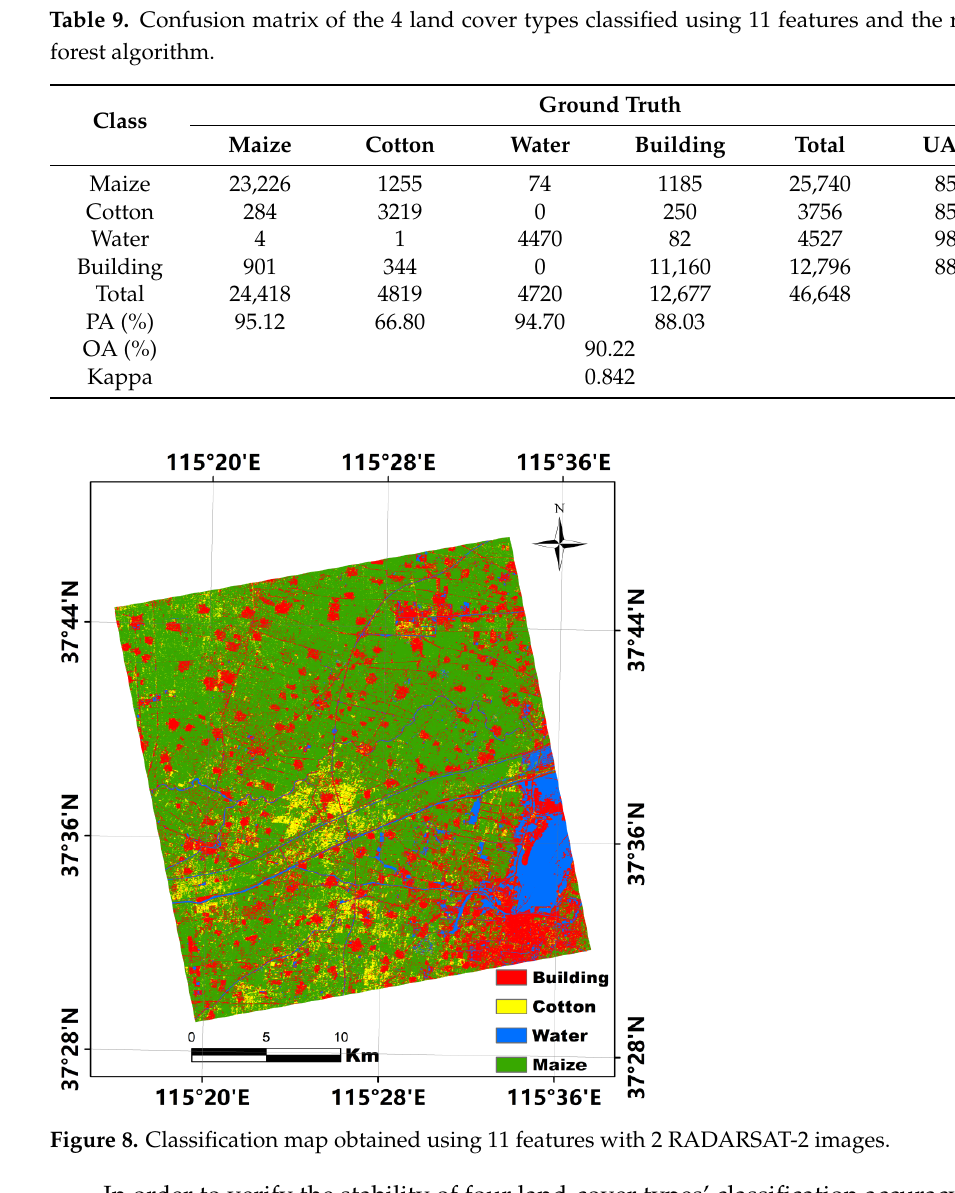
Table 10. Accuracies and Kappa coefficients of the classification of four land-cover types using 11 features and different training and validation samples. (TS 1 , TS r and VS 1 denotes the same mean- ing as in Table 8).